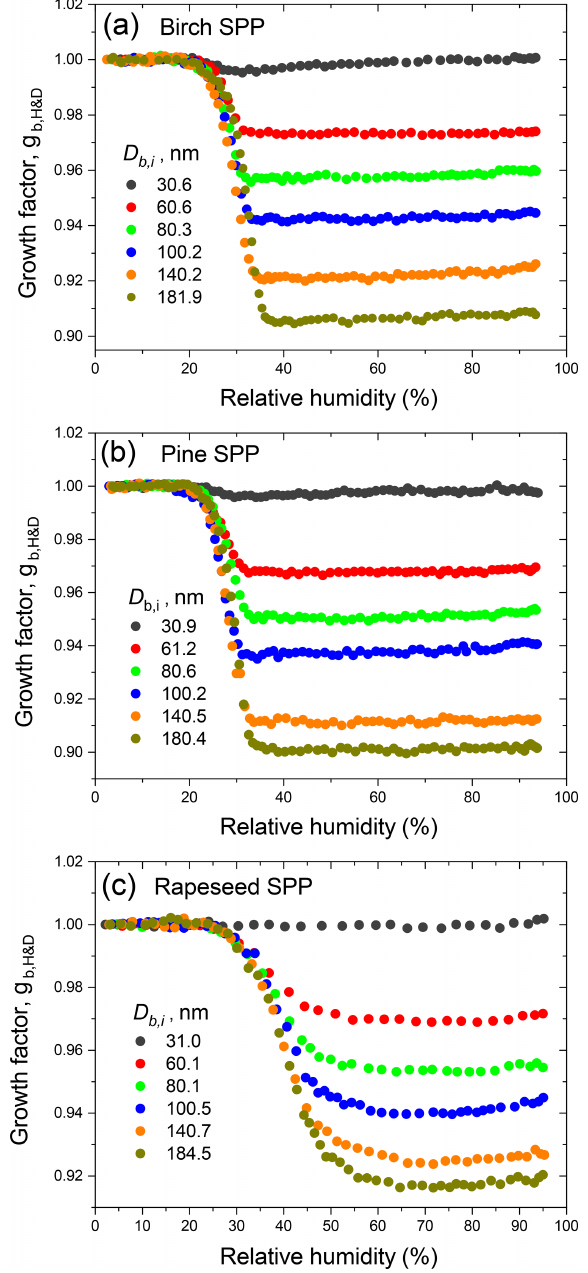
Figure 3. Growth factors ( g b, H&D ) of birch (a) , pine (b) , and rape- seed (c) SPPs as a function of relative humidity observed for differ- ent initial mobility diameters ( D b,i ) in hydration and dehydration (H&D) HHTDMA experiments.